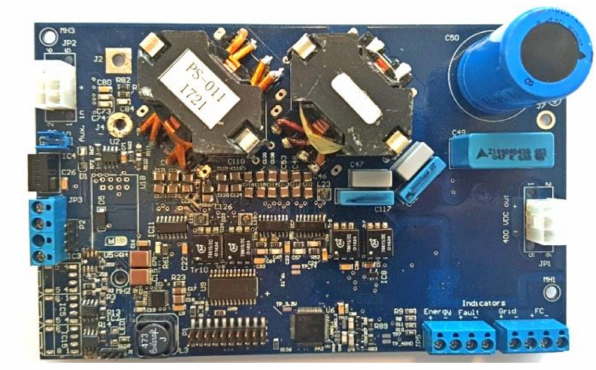
Figure 9. General view of the 300 W experimental prototype of the qZS IBBC based